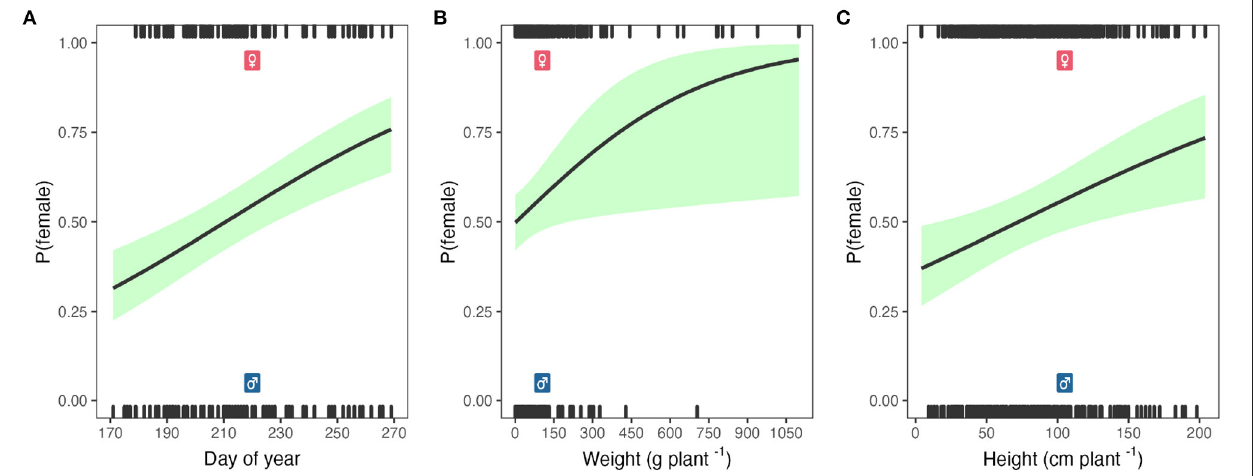
FIGURE 6 | The probability (P) of being female Palmer amaranth by doy (A) , weight (B) , and height (C) . Black line represents the model estimation and shaded green the confidence